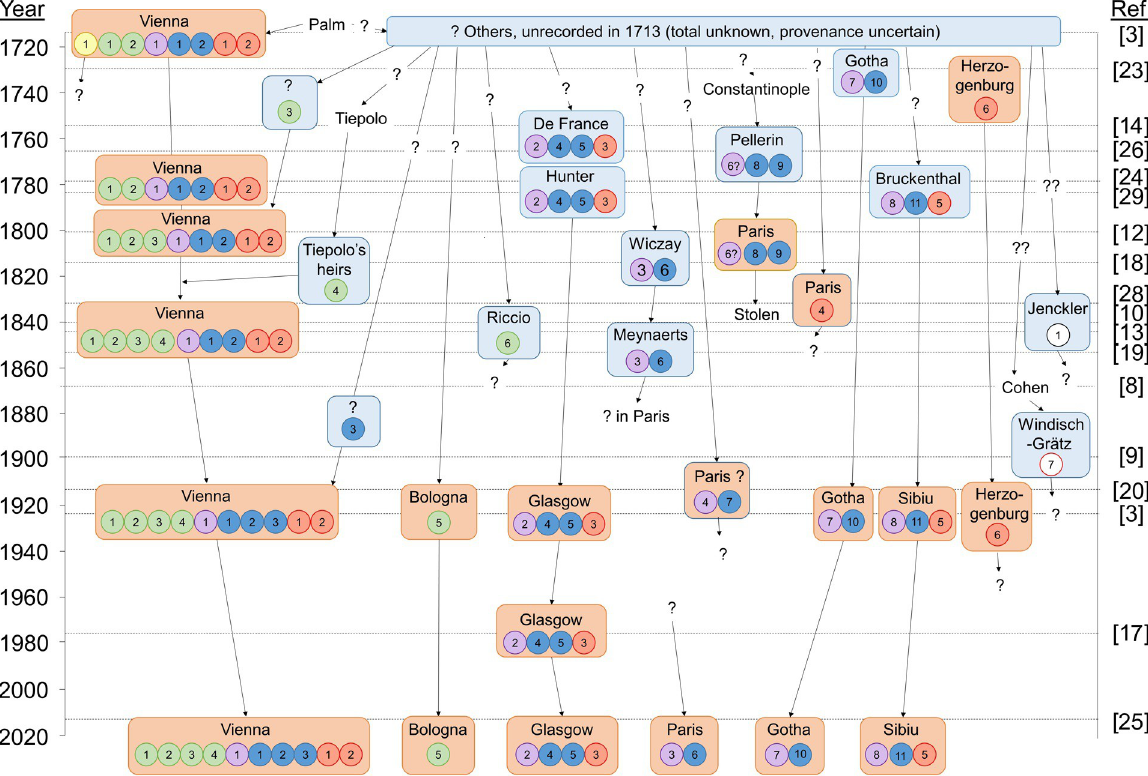
Fig 3. Diagrammatic representation of known and likely provenance trails of the wider assemblage. Yellow = Type 1, green = Type 2, purple = Type 3, dark blue = Type 4, dark orange = Type 5, white with red outline = Type 6, white with black outline = Type 7. Numbers correspond to individual coins of each type as given in Table 1. Orange boxes = public collections, light blue boxes = private collections. Apart from the Glasgow group discussed herein, confirmed coins are Vienna Mu¨nzkabinett RO ¨ 32.227 and RO ¨ 32.228; Bologna, Museo